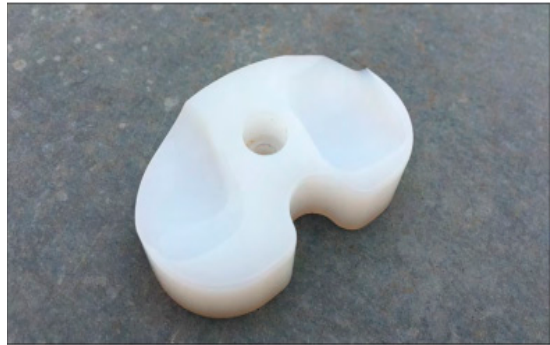
Figure 2. CNC milling tibial geometry [12].